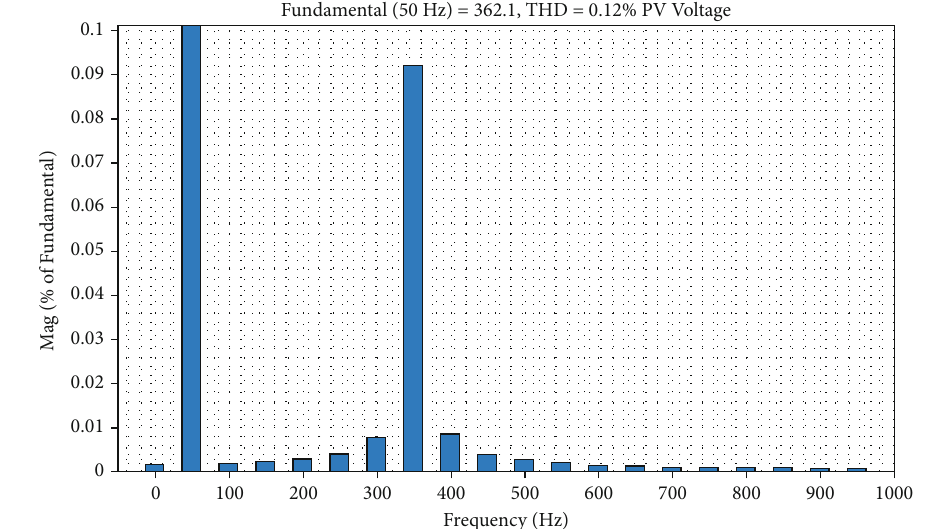
Figure 34: THD values of PV system